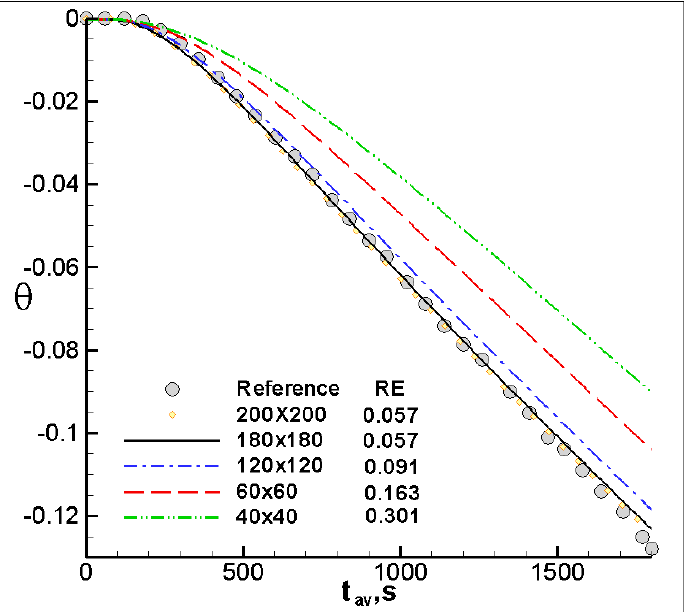
Figure 3. Time evolution of the average dimensionless fluid temperature for five meshes is compared with [38] by using relative error (RE). Results were obtained using a constant temperature of θ = − 1 outside the container for the first case in Section 3.1.